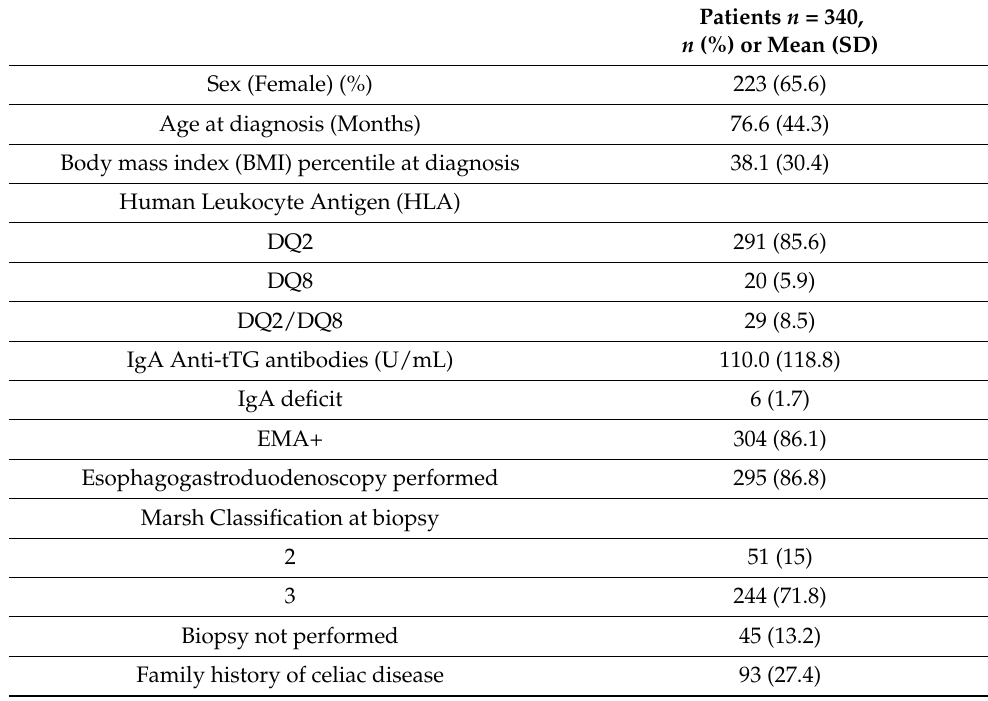
Table 1. Demographic and clinical characteristics of celiac disease patients enrolled into the